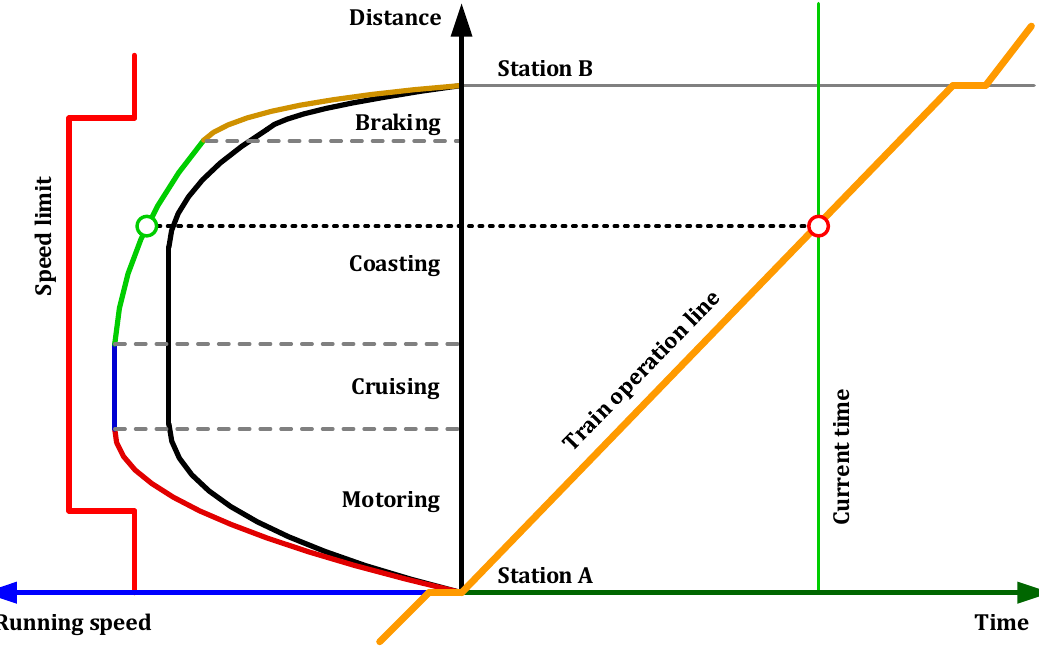
Figure 2. Typical train movement modes and the relationship with the train plan.